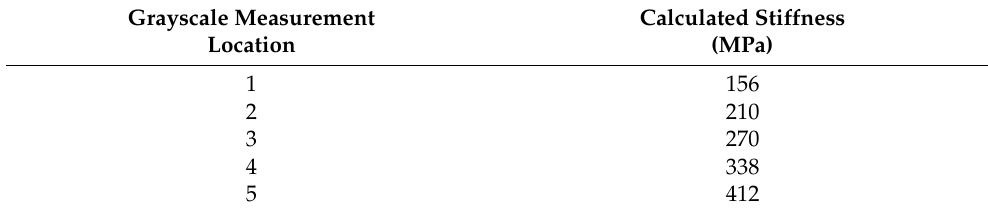
Table 5. Bone Stiffness